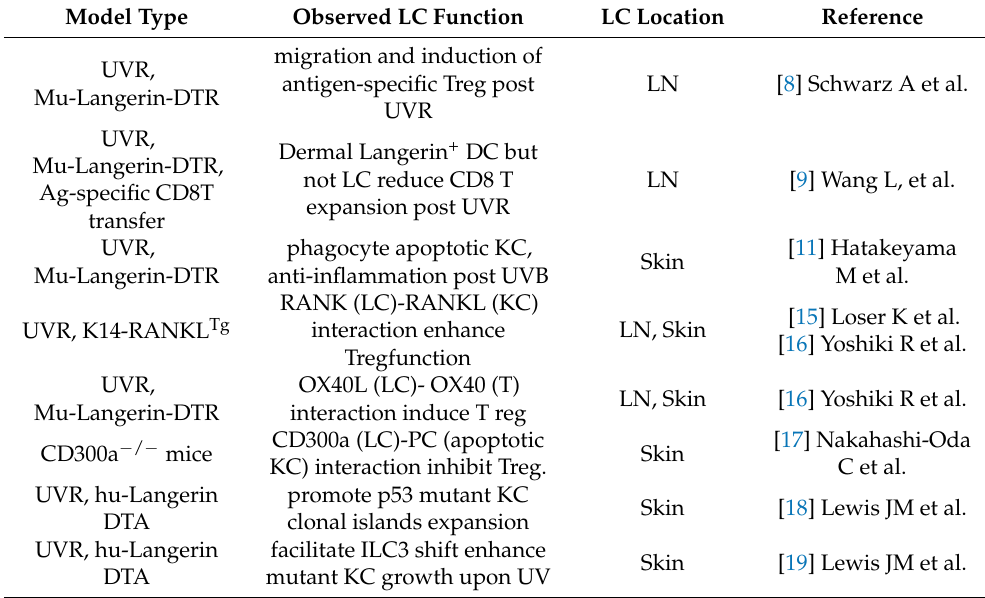
Table 1. Langerhans cells in UV-mediated immune